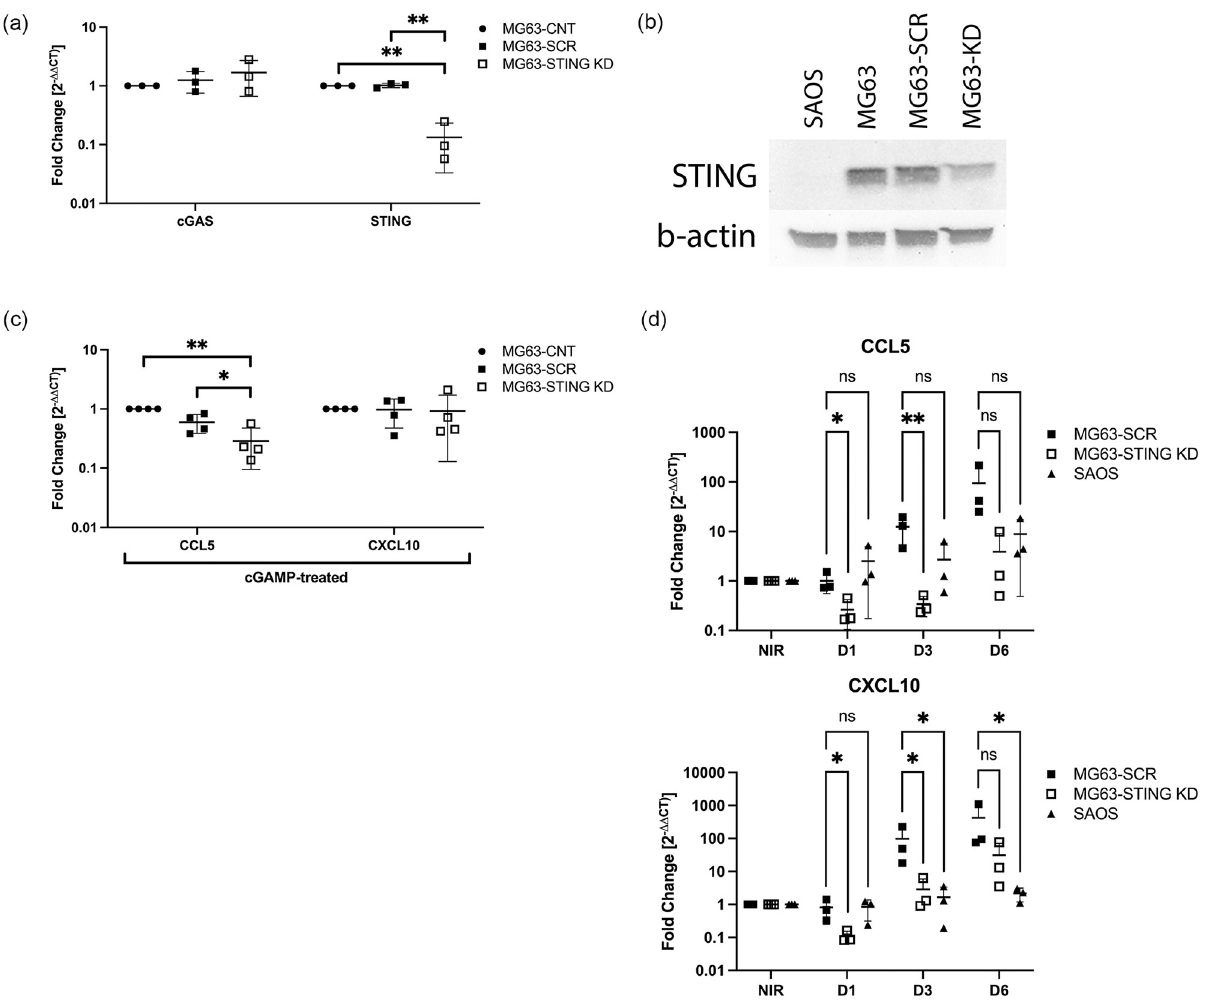
Fig 4. Dependence on STING expression for radiation-induced chemokine expression. A) mRNA expression of cGAS and STING depicted as fold change (2 - ΔΔ Ct ) in MG63-STING KD cells relative to MG63-SCR and MG63-CNT cells. N = 3. B) STING protein expression in SAOS, MG63-CNT, MG63-SCR, and MG63-STING KD cells by Western blot. A representative image is shown, depicting STING expression (~35 kDa) and the loading control, β -actin (~45 kDa). Three independent replicates were performed. C) CCL5 and CXCL10 expression in MG63-STING KD, MG63-SCR and MG63-CNT cells exposed to 2’3’-cGAMP (10 μ g/mL for 16 hrs). N = 4. D) Expression of chemokines by STING-deficient MG63-STING KD and SAOS cells, and STING-expressing MG63-SCR cells after exposure to 5 Gy ionizing radiation. Expression of CCL5 and CXCL10 is shown at 1 day (D1), 3 days (D3), and 6 days (D6) post radiation exposure relative to non-irradiated cells (NIR). Expression is compared between cell lines for each timepoint. RT- qPCR was performed in duplicate. The y-axes are represented on a log 10 scale. Individual data points are plotted, mean and SD are shown. ns = not statistically significant; * p < 0.05, ** p <